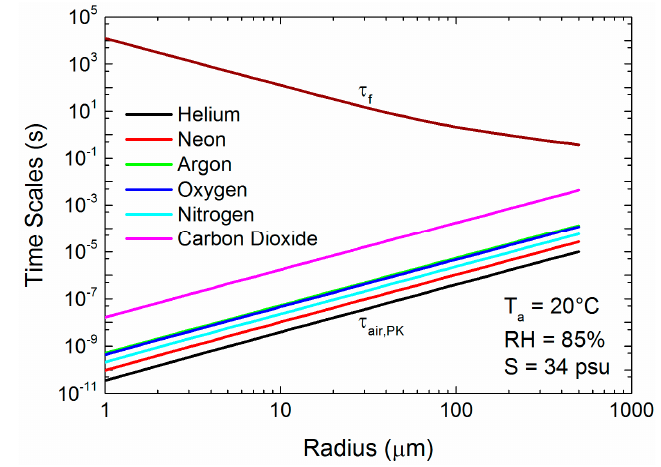
Figure 6. The time scale that governs gas transfer between the ambient air and the surface of a spray droplet derived from Pruppacher and Klett’s [43] approach, τ air,PK , (2.11), for six different gases. The plot also shows the residence τ f for a 10-m wind speed of 12 m s − 1 . Air ( T a ) and water temperature are assumed to be 20 °C, relative humidity ( RH ) is 85%, and sea surface salinity ( S ) is 34 PSU.